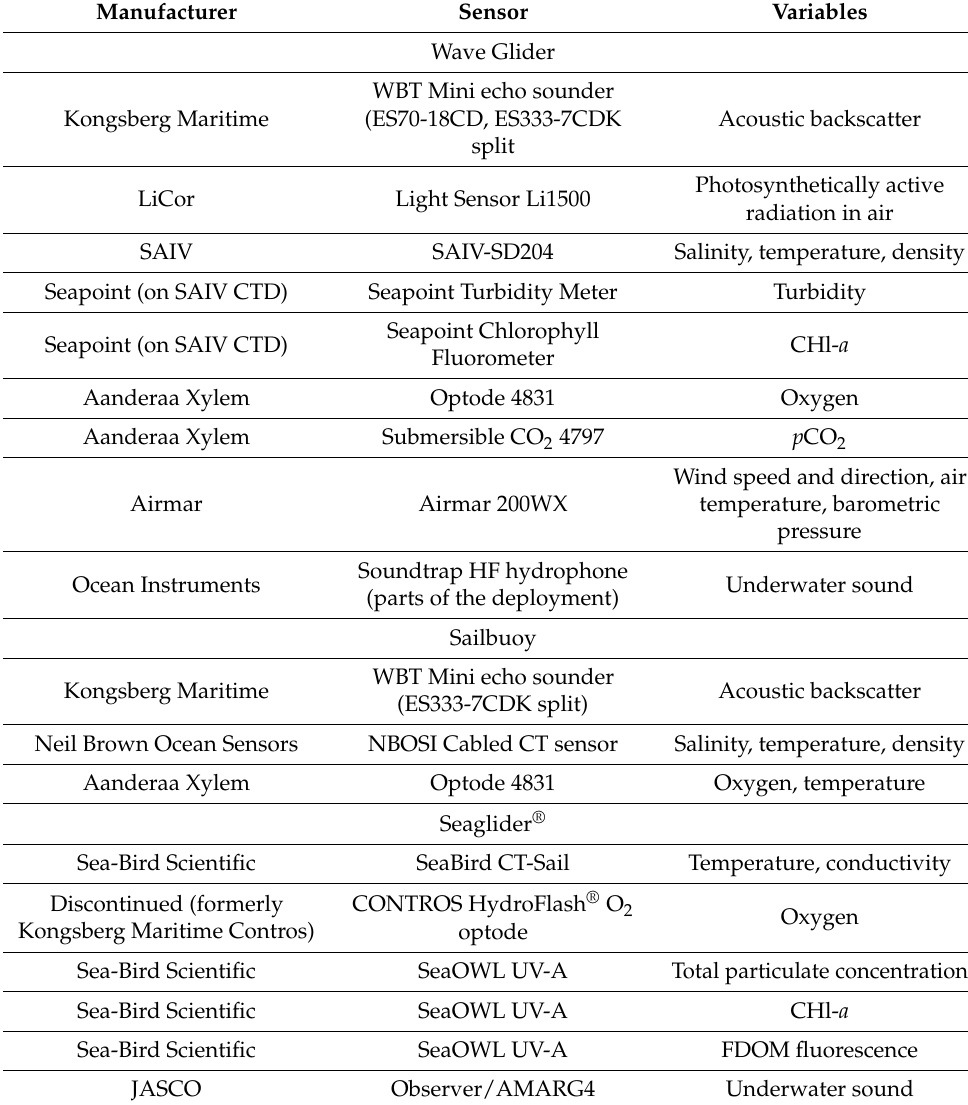
Table 1. Sensors integrated on the gliders for the 2018 LoVe